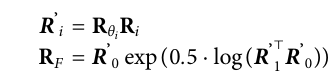
with the mid point i